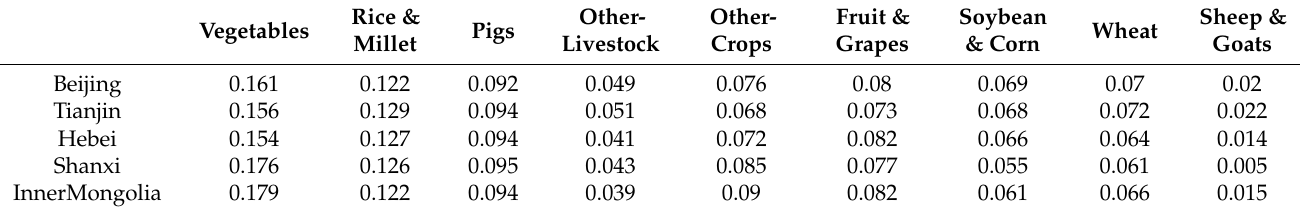
Table 1. Changes in agricultural production output in 31 provinces under LIS scenario (%).